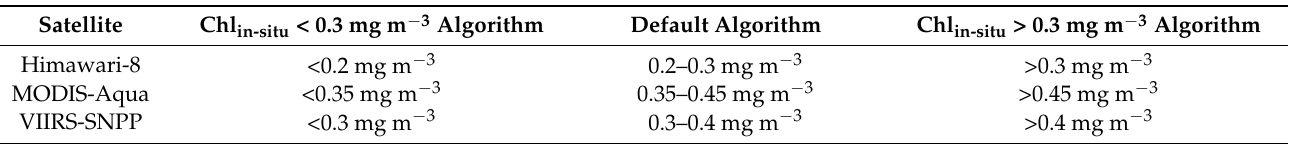
tration in the final